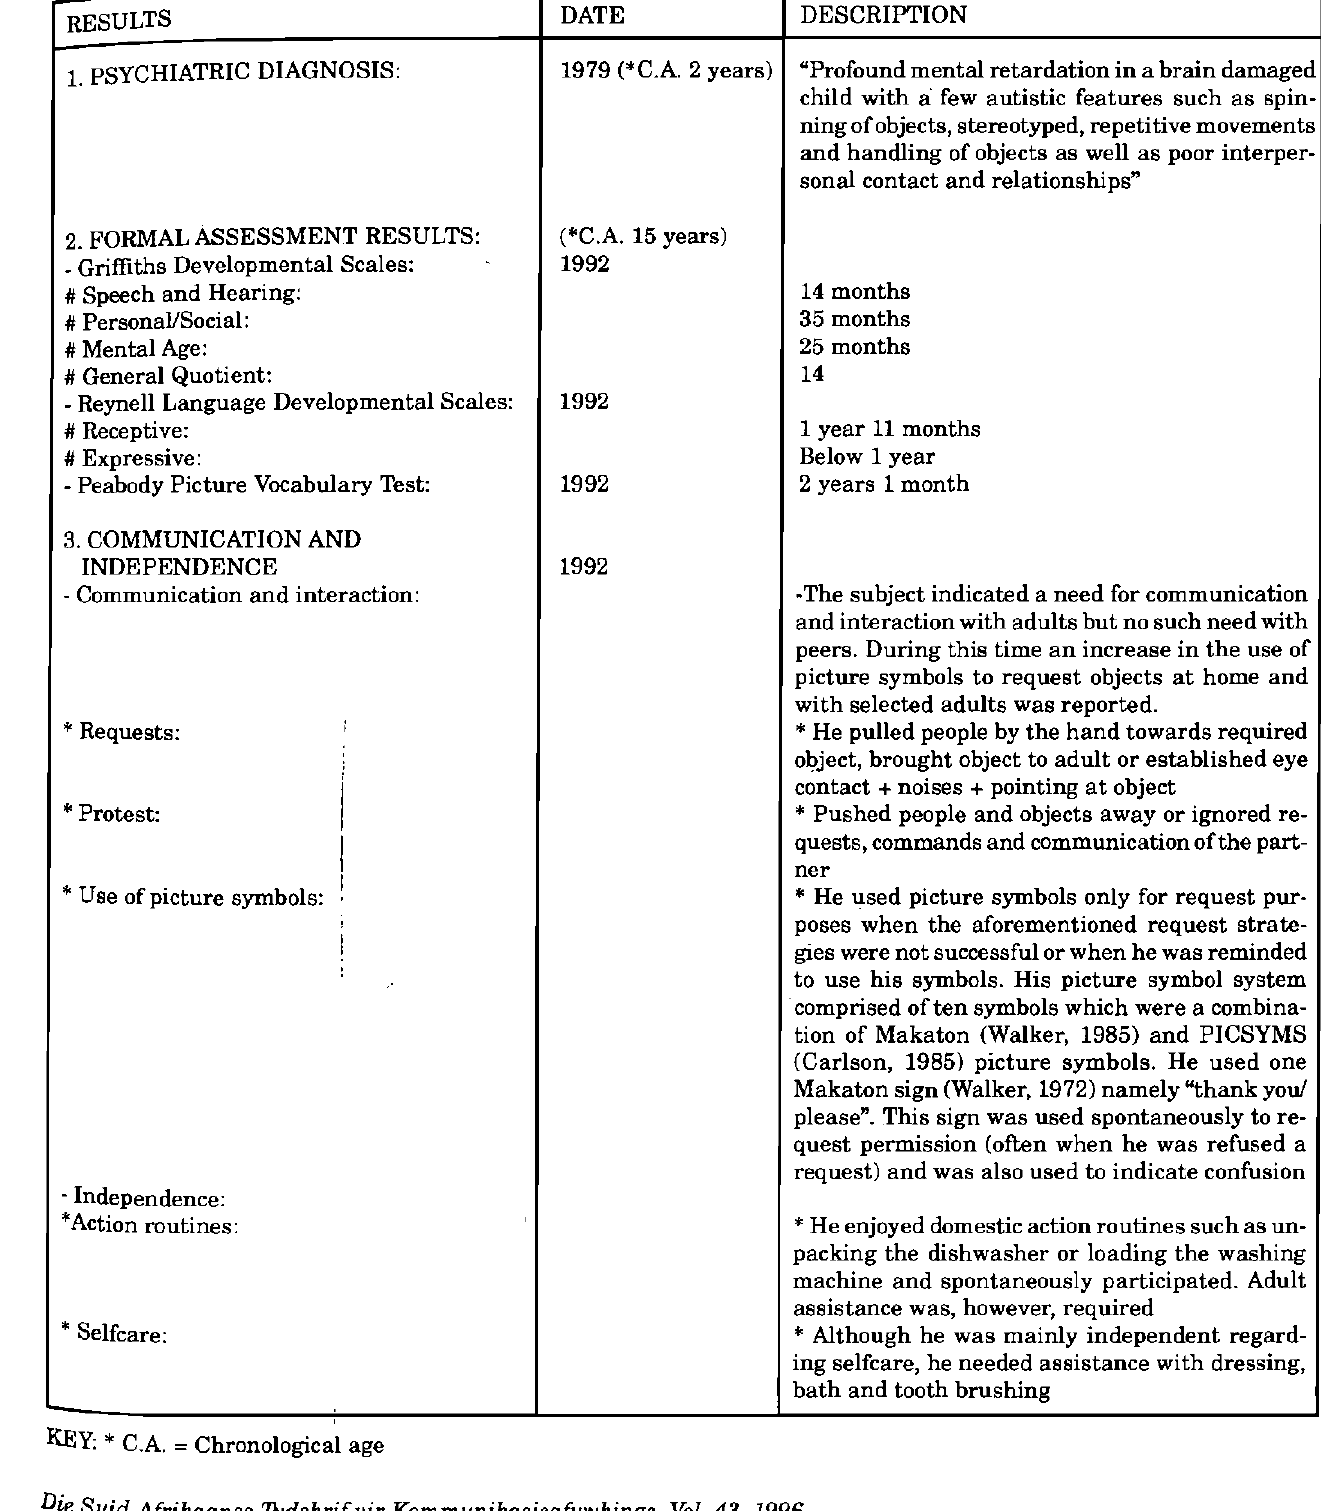
TABLE 2: Subject: Psychiatric diagnosis, formal assessment results, communication and independence skills